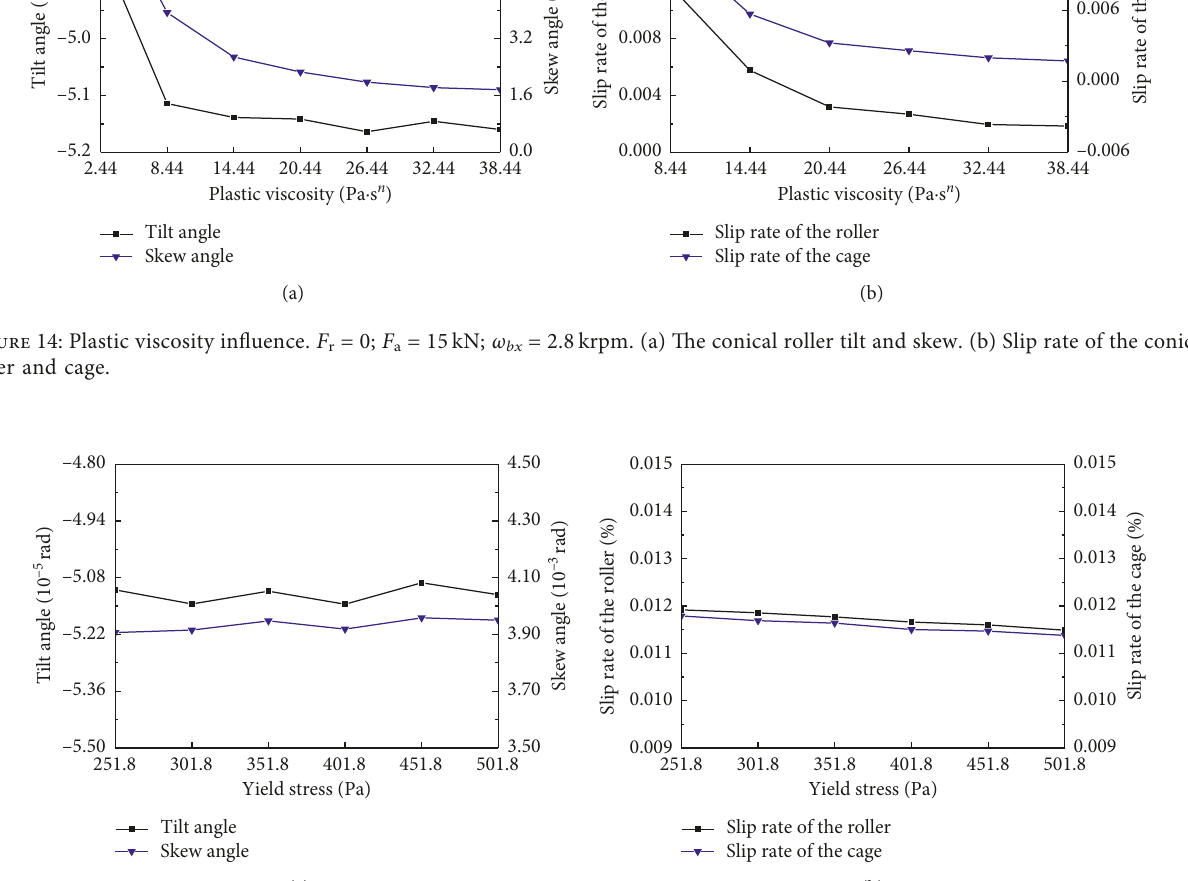
� 0; F � 15kN; ω � 2.8krpm. (a) The conical roller tilt and skew. (b) Slip rate of the conical roller and r a bx